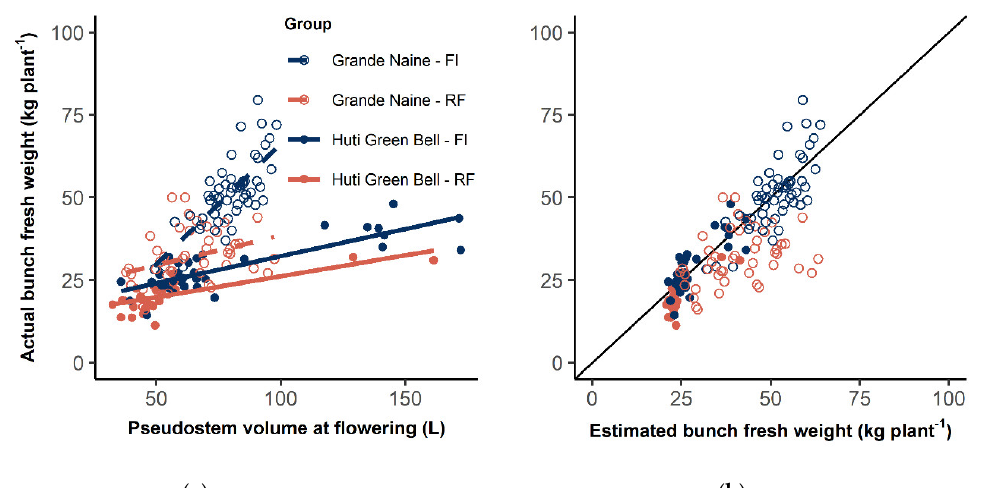
Figure 5. Bunch fresh weight (bunchF, kg plant −1 ) models. ( a ) Actual bunchF vs. pseudostem volume at flowering (V pseudo, Flower , L) for Huti Green Bell (HG) and Grande Naine (GN). Regression models were specific models for treatment and cultivar as shown in Table 4; ( b ) Comparison of actual bunchF (kg plant -1 ) with estimated bunchF (kg plant -1 ) as obtained using the specific regression models for treatment and cultivar as shown in Table 4. FI notes full irrigation, RF notes rainfed.